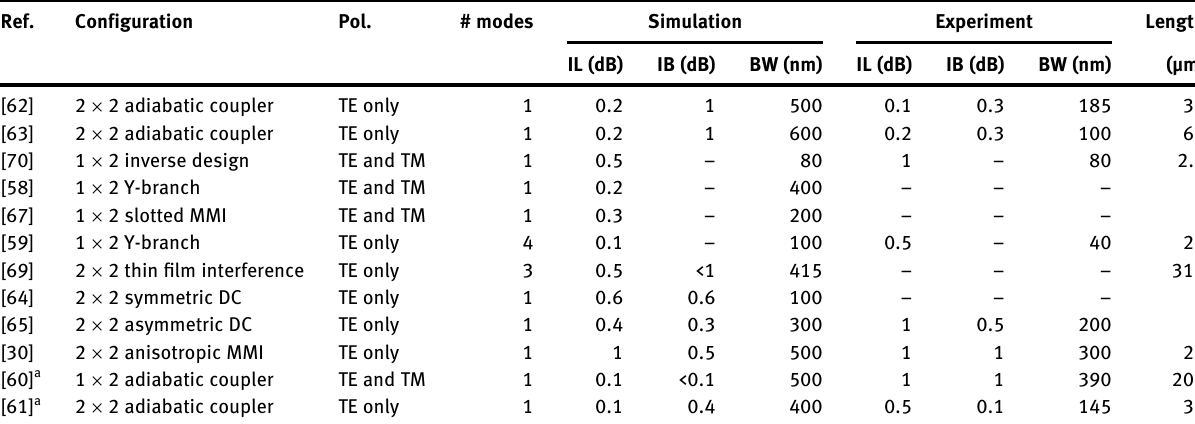
Table  : Performance comparison of recently demonstrated subwavelength-enhanced on-chip beam splitters. All devices operate at near- infrared wavelengths.